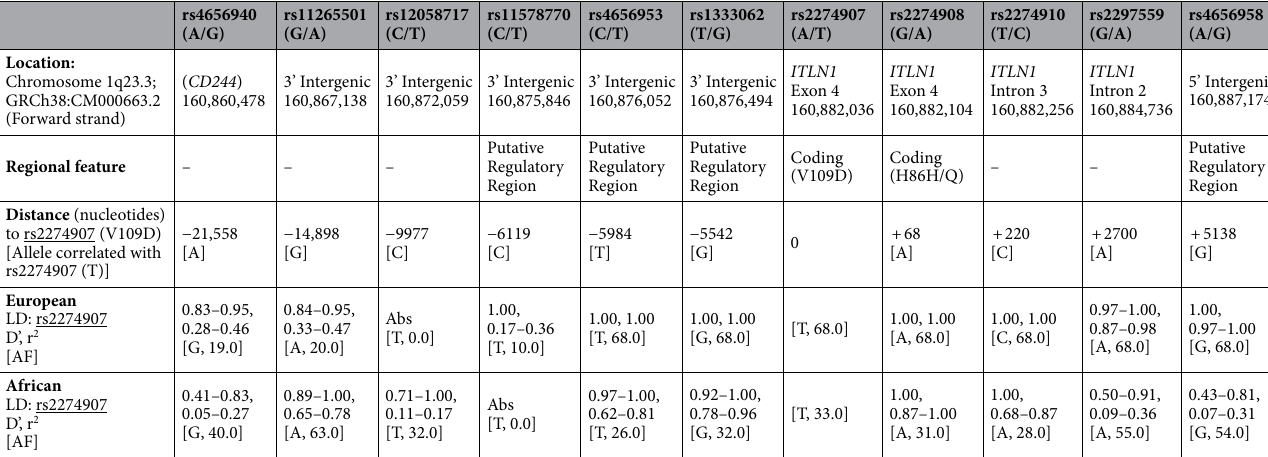
Table 1. European and African superpopulation haplotype analysis at the ITLN1 locus. LD, linkage disequilibrium; AF, allele frequency; Abs, absent. D’ and r 2 values represent co-inheritance range (i.e., lowest and highest values) for each sub-population within African and European superpopulations 32,35 .